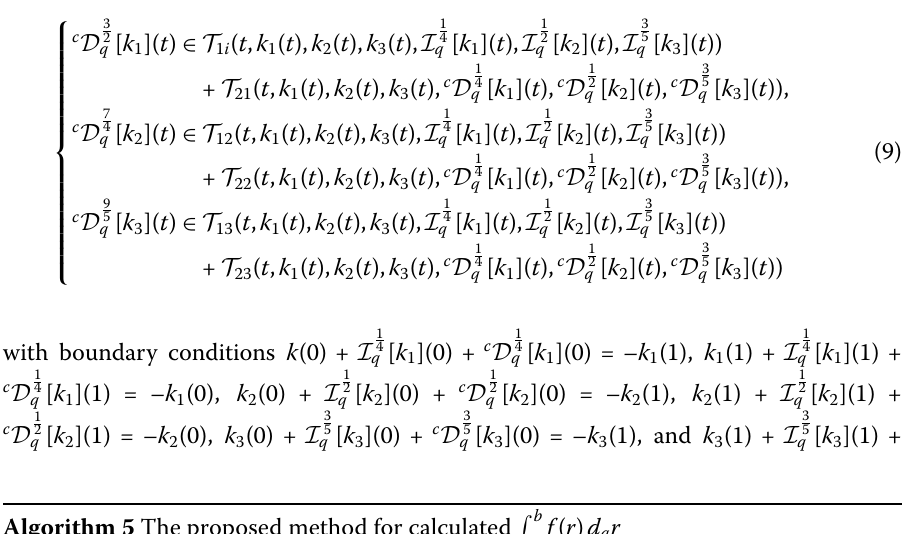
Algorithm 5 The proposed method for calculated